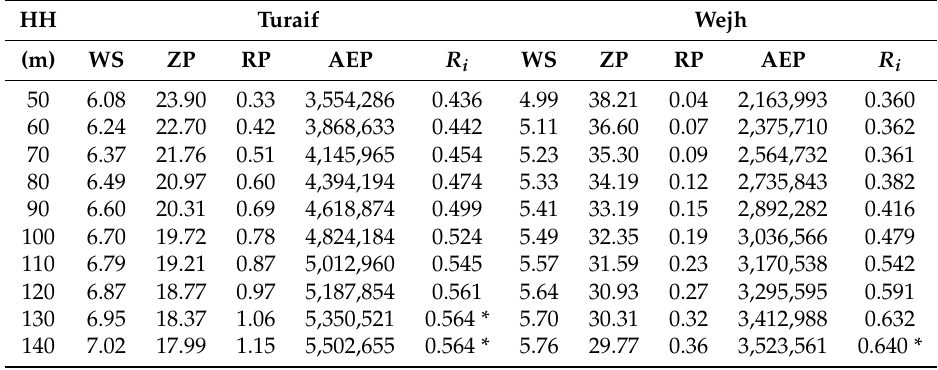
Table A3. TOPSIS analysis for turbine DeWind D92. The best choice for each site is marked with an